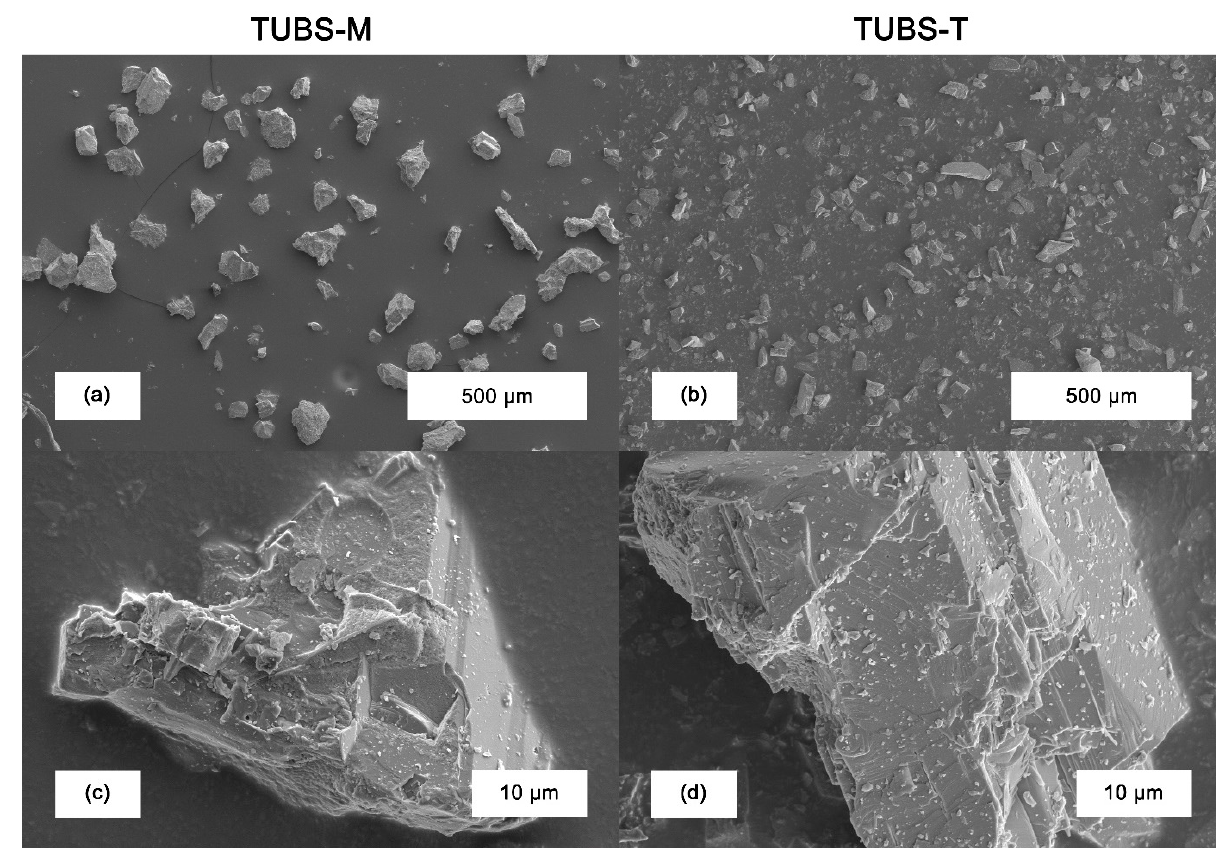
Figure 4. TUBS-M ( a ) and TUBS-T ( b ) particles of the size fractions 45–90 µm and 25–45 µm, respectively; surface structure of a single particle of the size fraction <25 µm for TUBS-M ( c ) and 25–45 µm for TUBS-T ( d ).